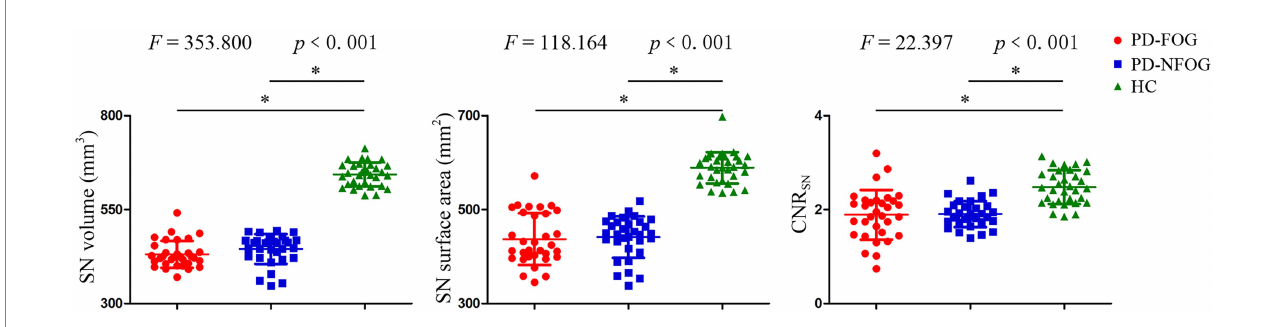
FIGURE 2 Substantia nigra volume, surface area and CNR among PD-FOG, PD-NFOG, and HC groups. CNR, contrast to noise ratio; SN, substantia nigra; * p <